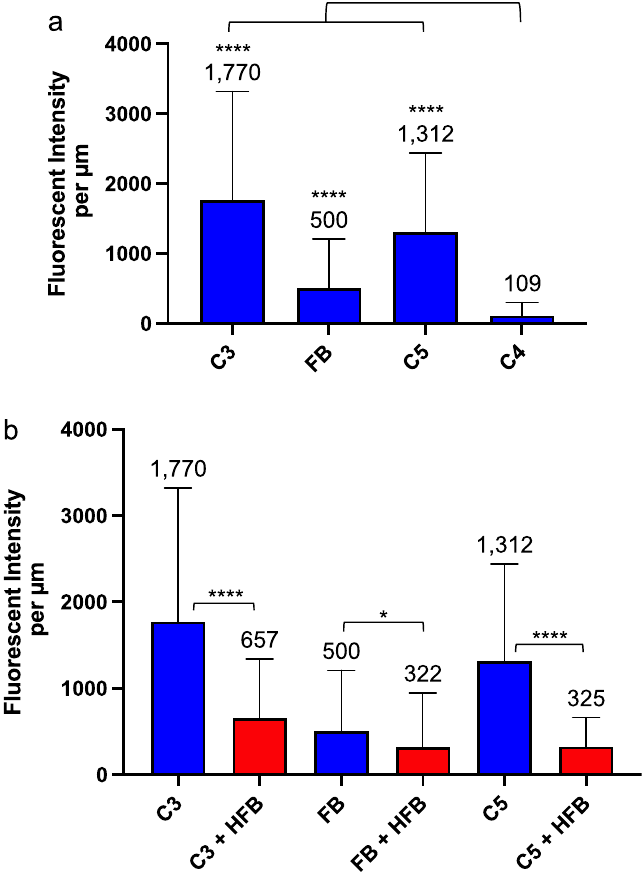
Figure 6. Quantification of GMVEC-released complement proteins attached to GMVEC-secreted ULVWF strings in the presence or absence of HFB. Intensities of GMVEC-released complement proteins were measured along ULVWF strings secreted in response to: ( a ) 100 µM histamine; and ( b ) histamine ± 20 µg/ml HFB. Shown are the complement component fluorescent intensities per micron of ULVWF string length after background string subtraction. Values are means plus SD; n = 65–151 strings for proteins without HFB (blue bars) and 151– 320 strings for proteins with HFB (red bars). Data were compiled from 3 to 9 experiments per condition and over 800 fluorescent images. In ( a ), values for C3, FB and C5 are statically different from C4 (****P < 0.0001); and in ( b ), paired comparison values for C3 and C3 + HFB (****P < 0.0001), C5 and C5 + HFB (****P < 0.0001) and FB and FB + HFB (*P = 0.0311) are statistically different by one-way ANOVA, non-parametric